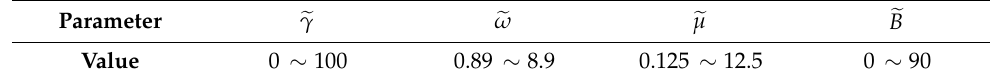
Table 2. Dimensionless parameters.